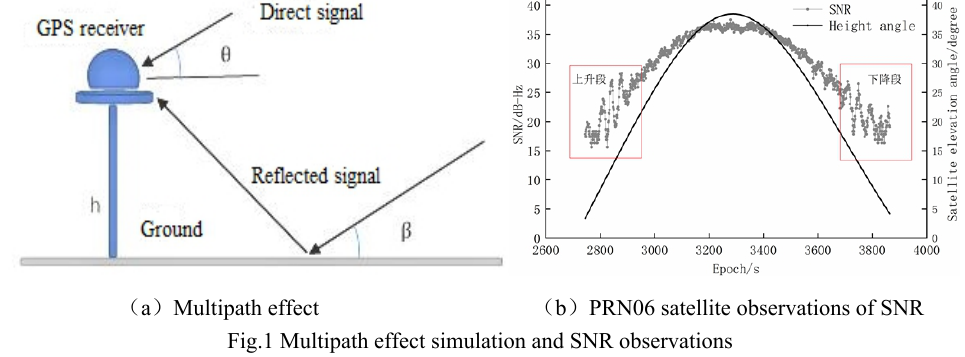
Fig.1 Multipath effect simulation and SNR observations